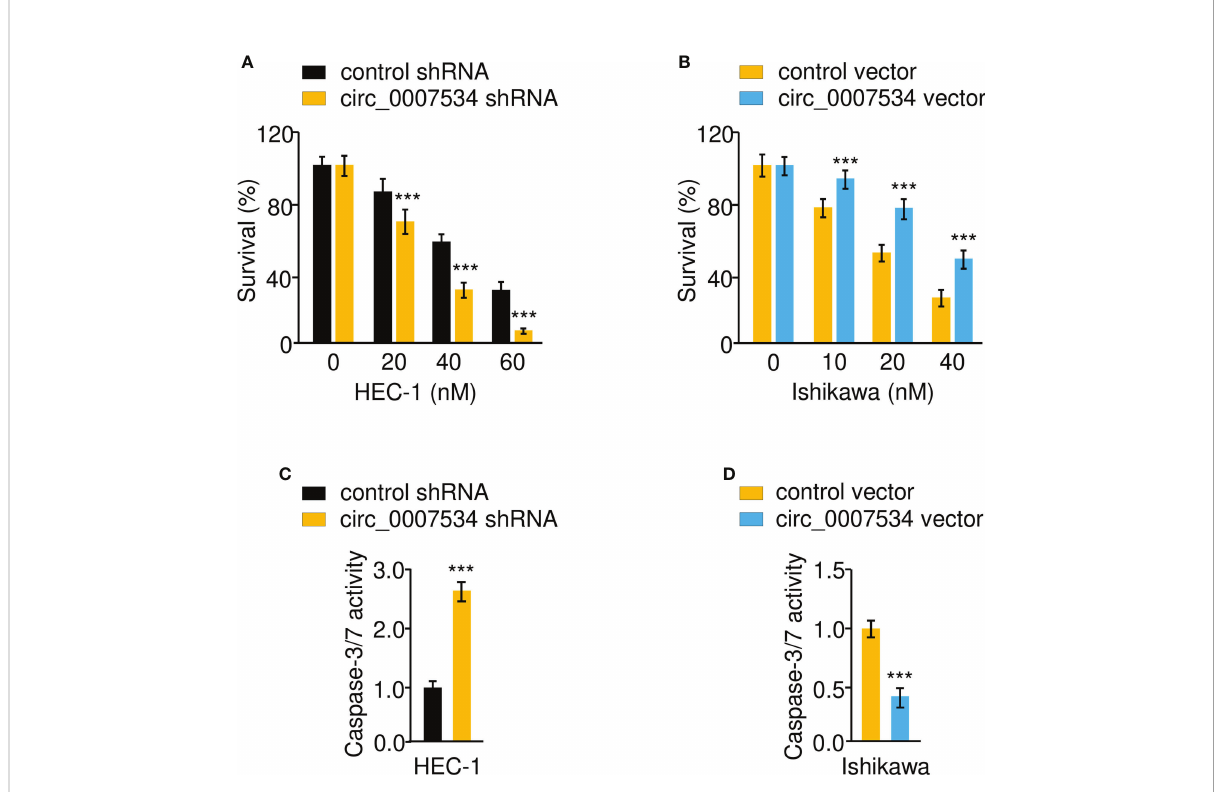
FIGURE 4 Circ_0007534 suppresses the sensitivity of endometrial cancer cells to paclitaxel. (A, B) The indicated HEC-1 (A) and Ishikawa (B) cells were treated with various concentrations of Paclitaxel for 24hours, and cell viability was determined using a CCK-8 assay. (C, D) The activities of caspase-3 and caspase-7 in HEC-1 (C) and Ishikawa (D) cells were analyzed with Caspase-Glo 3/7 assays. *** P <